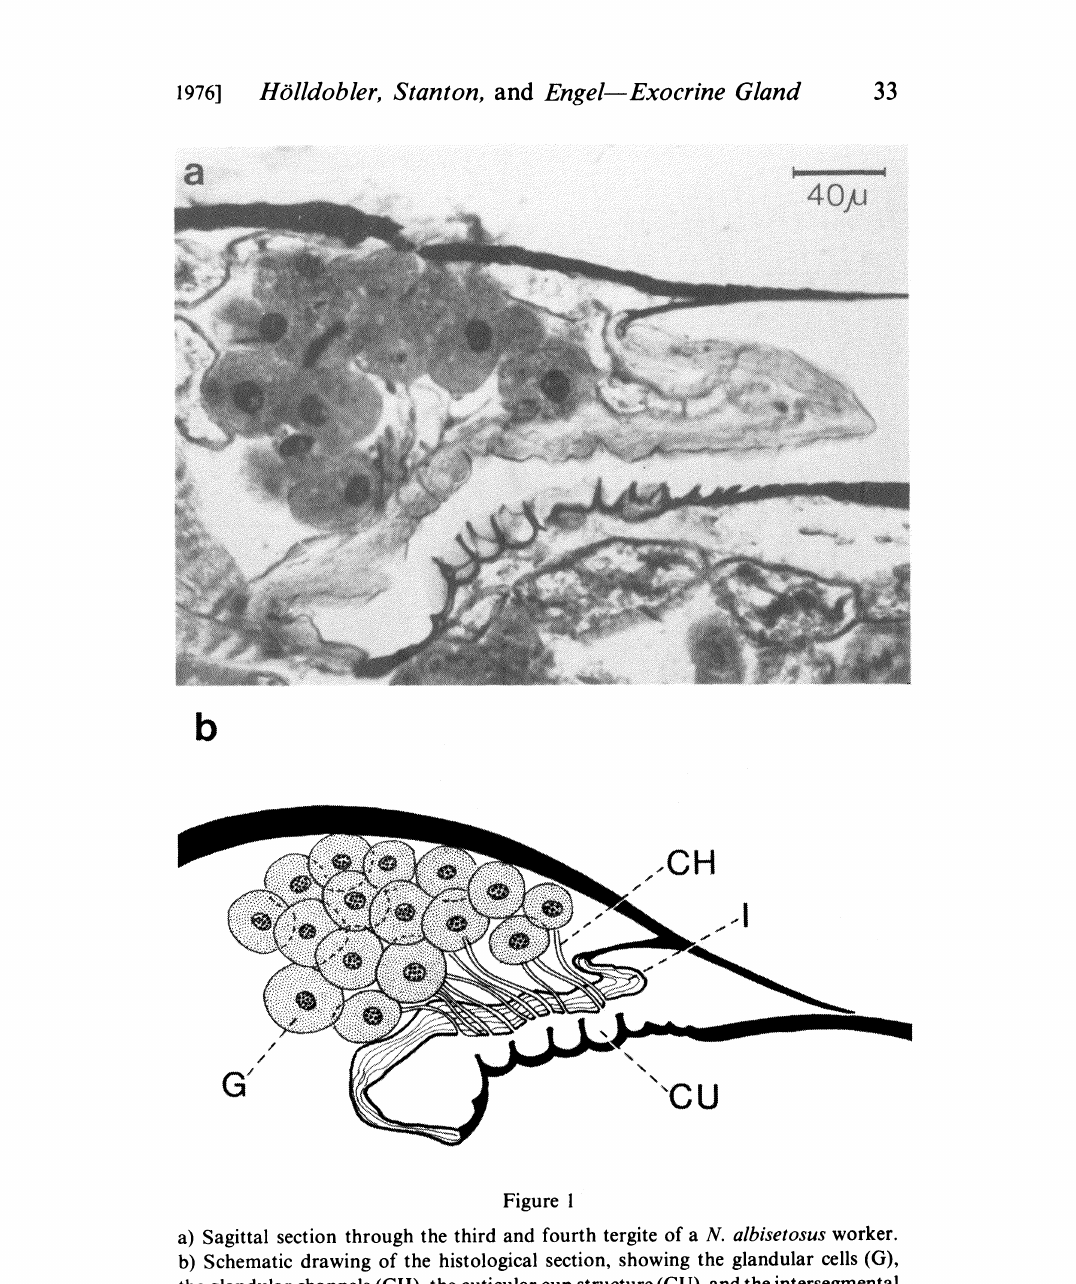
a) Sagittal section through the third and fourth tergite of a N. albisetosus worker. b) Schematic drawing of the histological section, showing the glandular cells (G), the glandular channels (CH), the cuticular cup structure (CU), and the intersegmental membrane (I) between the third and fourth